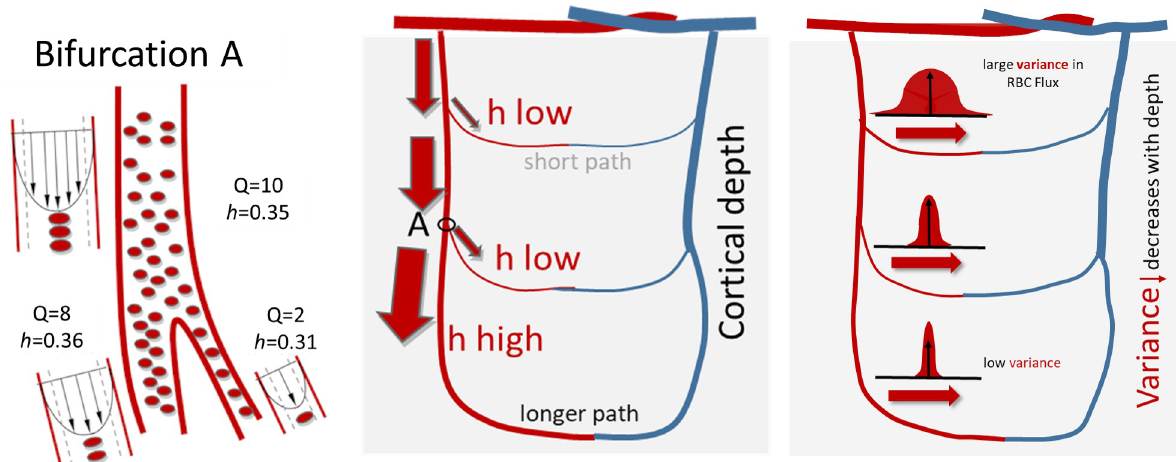
Fig 8. Schematic of the depth dependent hematocrit network effect. At the microcirculatory level, blood is a suspension of red blood cells in plasma with a thin boundary layer close to the vascular wall which contains little or no red blood cells. When red blood cells suspended in plasma flow through a bifurcation of a penetrating artery, they tend to concentrate in the thicker daughter branch, while the thinner side branch syphons a comparatively higher fraction of plasma from the cell free layer near the wall of the parent branch. This effect is known as plasma skimming . When plasma skimming repeats over many bifurcations of the cortical microcirculation, deeper reaching paths through the capillary bed tend to have higher hematocrit than surface paths. Longer path length incurs higher flow resistance leading to less bulk flow. In effect, total RBC flux, which is the product of hematocrit times flow, is more balanced than if RBC splits were even. The network effect also reduces variability in RBC fluxes, so that deeper layers are more evenly perfused. Our simulations implicated network effects due to biphasic blood rheology for the predicted hematocrit gradients and increased RBC flux